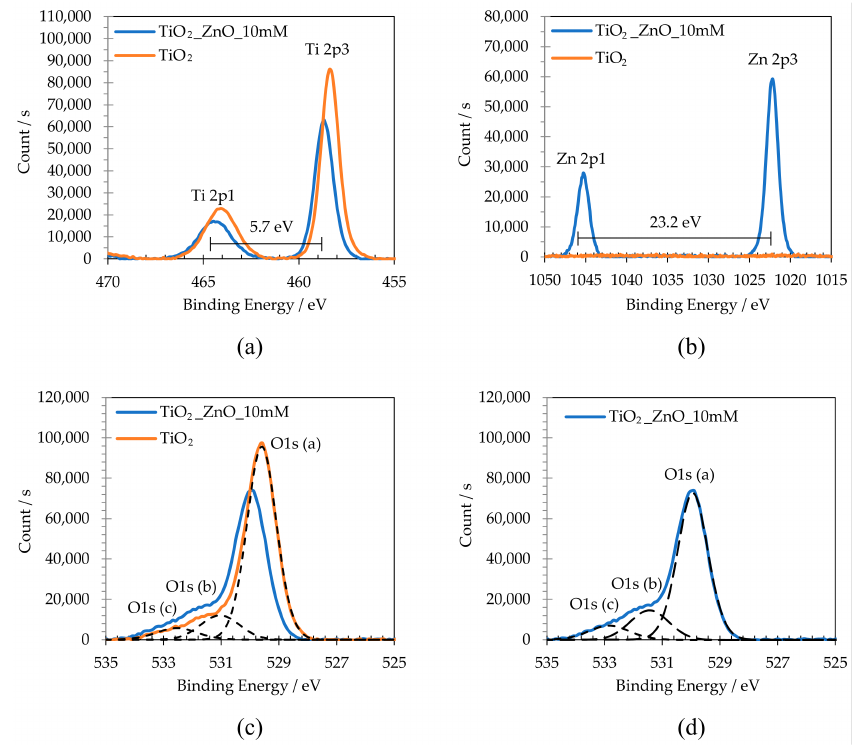
Figure 8. High-resolution XPS spectra of ( a ) Ti2p, ( b ) Zn2p, ( c ) and ( d ) O1s, of TiO 2 nanosponges and TiO 2 /ZnO hybrid nanosponges electrodeposited for 15 min at 75 ◦ C with 10 mM Zn(NO 3 ) 2 after the heat